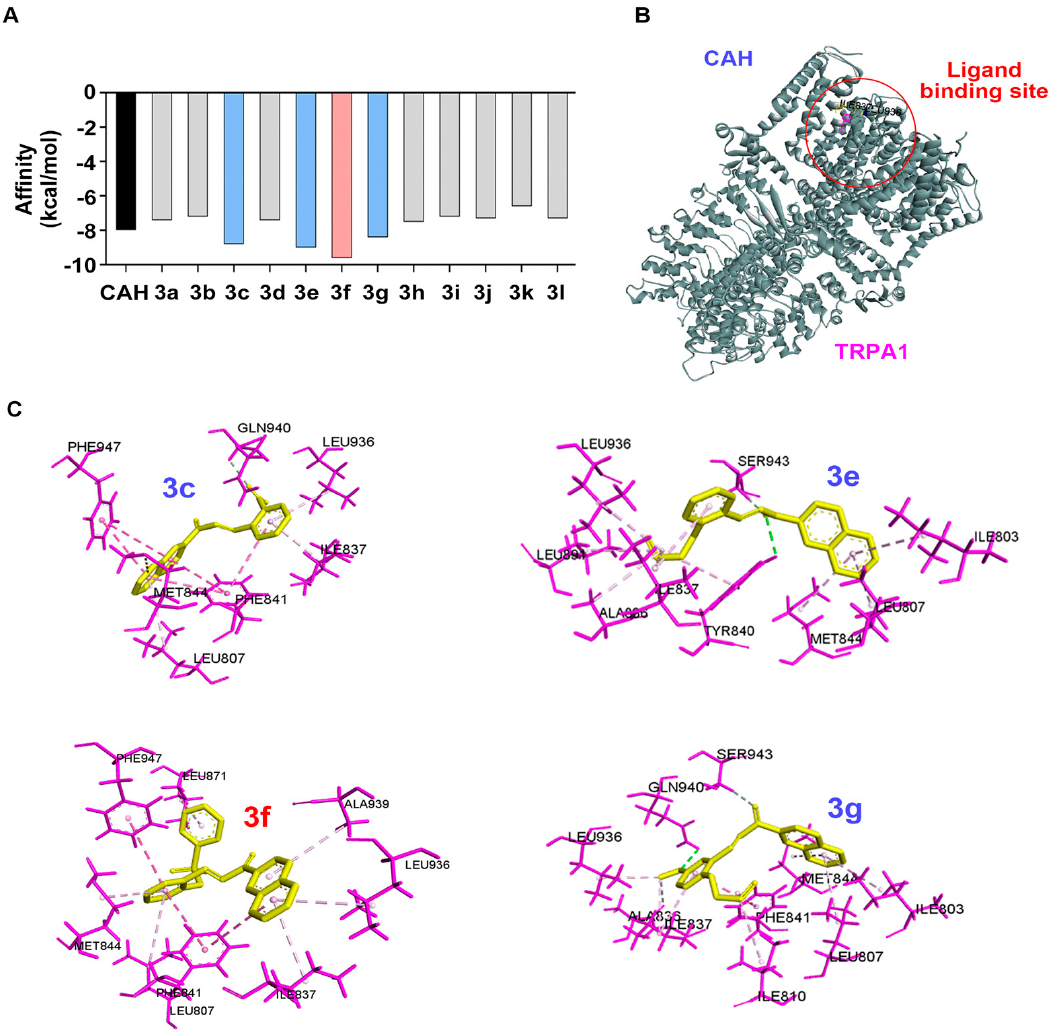
Figure 3. Docking-simulation results between TRPA1 and CAH derivatives. ( A ) The binding affinity energies (kcal/mol) of 3a − 3l with TRPA1 were estimated by AutoDock Vina software. ( B ) Three- dimensional structure of TRPA1 (PDB code: 6X2J) was used from the Protein Data Bank database (https://www.rcsb.org/; accessed on 10 March 2022). ( C ) Docking conformations of 3c , 3e , 3f , and 3g showing high affinity with TRPA1 were visualized, and the zoom-in view of each docked ligand inside the TRPA1 was displayed. The structure of ligands was represented as yellow, the residues in the ligands were indicated as pink, and predicted hot spots were shown as blue. CAH, cinnamal- dehyde.